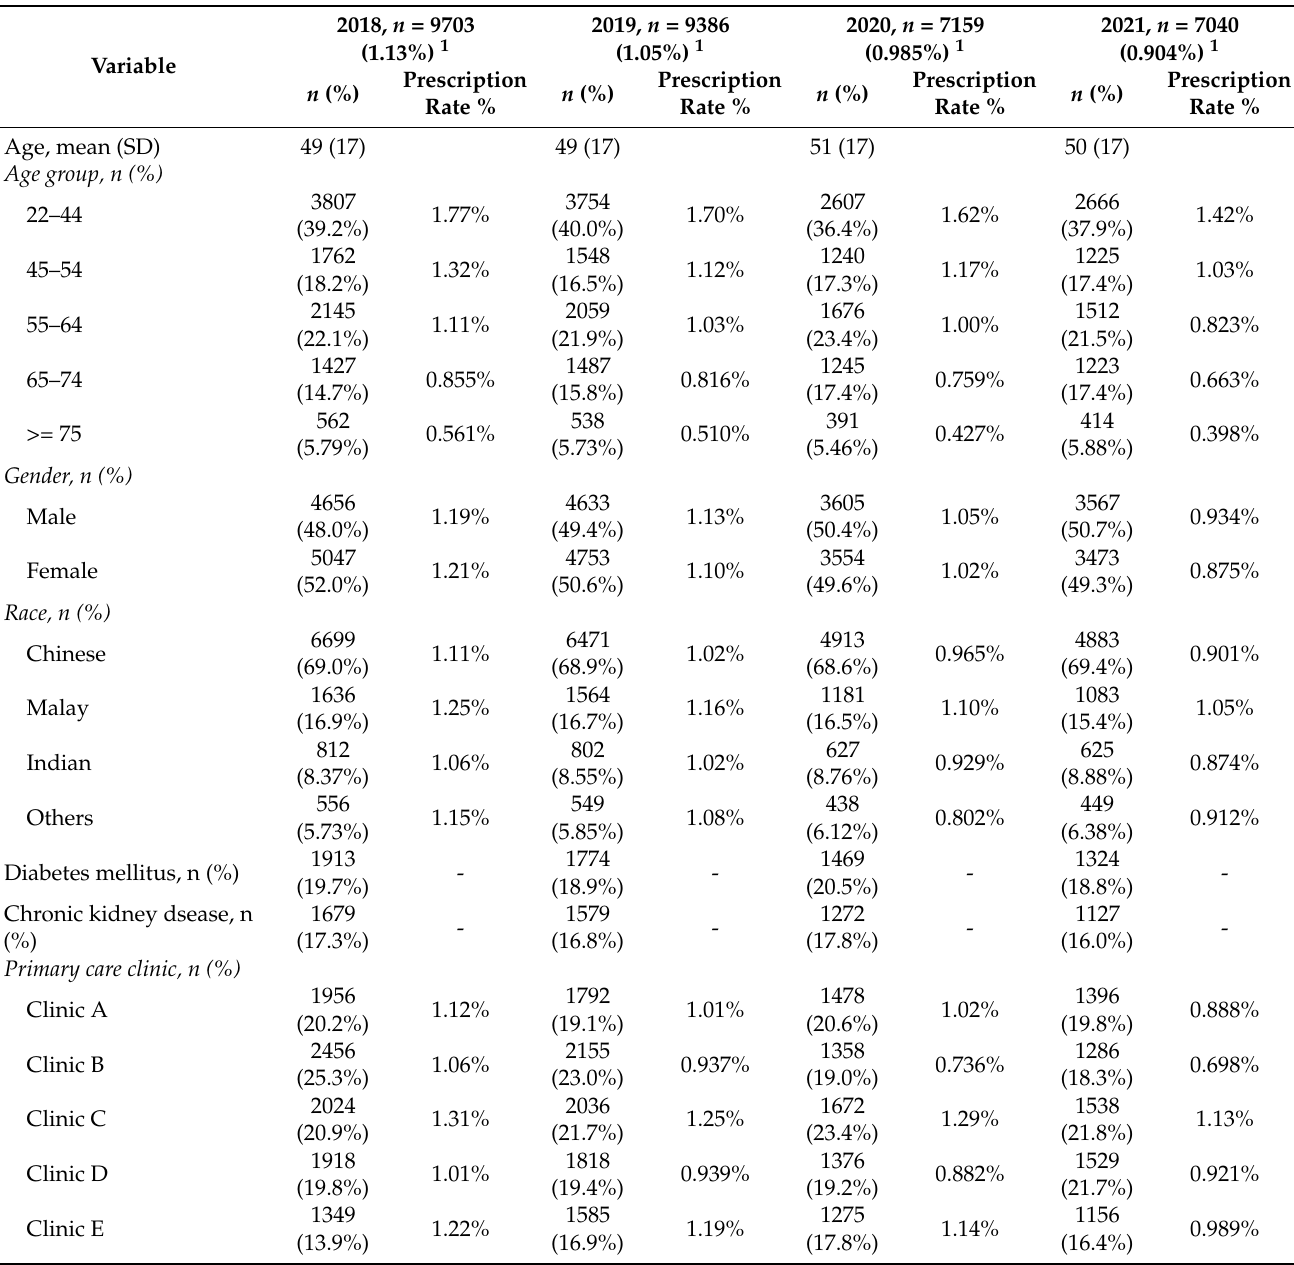
Table 4. Topical eye antibiotic prescriptions,